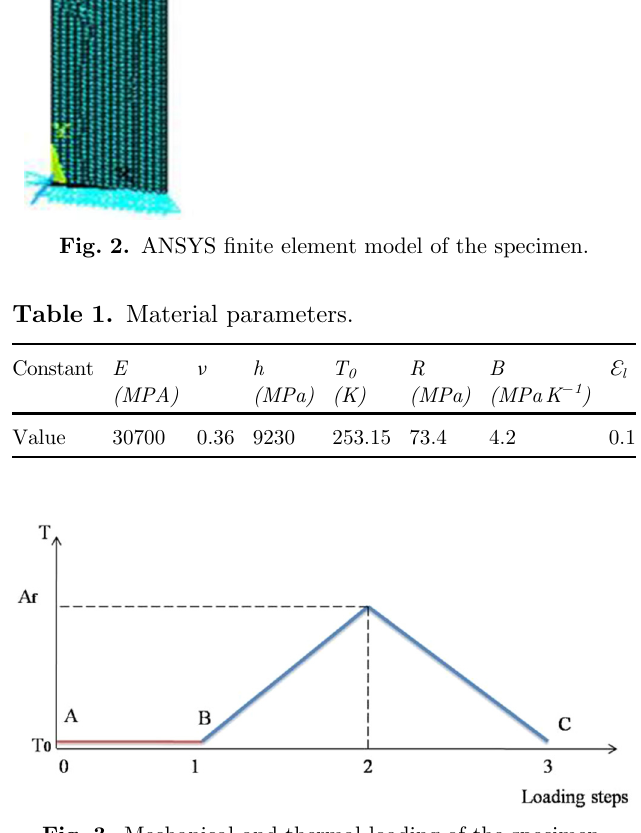
Fig. 3. Mechanical and thermal loading of the